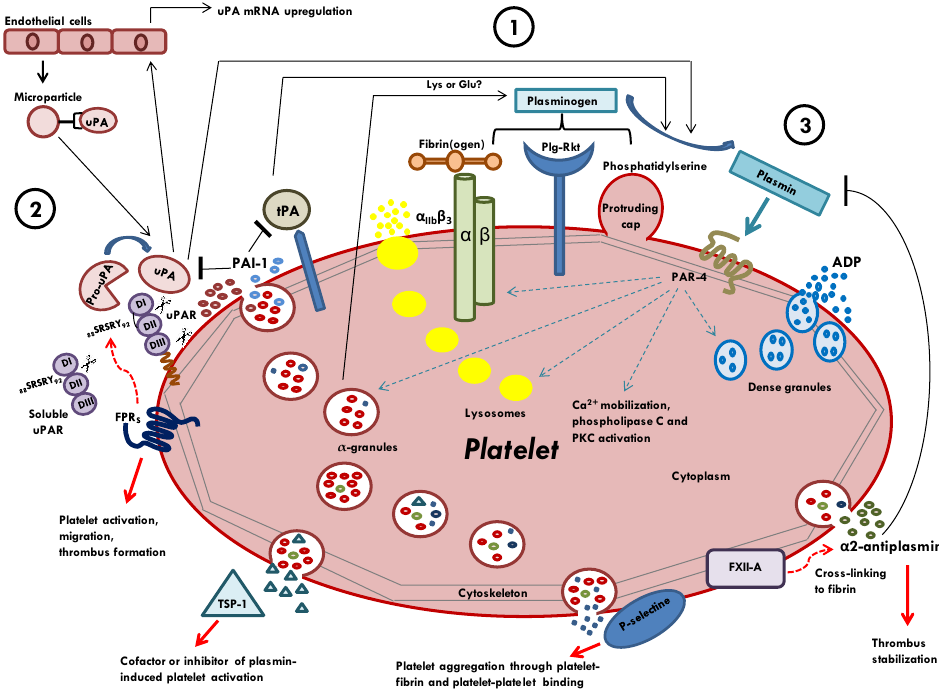
Figure 1. Representation of PAS components contained in or bound to platelets. ( 1 ) Plasminogen can be released from platelet α -granules after thrombin stimulation and can interact with specific receptors on the platelet surface: α IIb β 3, phosphatidylserine-exposing protruding caps, and/or Plg-Rkt, an integral transmembrane receptor. ( 2 ) The two main plasminogen activators are tPA and uPA. tPA derives from both platelets and plasma. Platelet receptors for tPA have not yet been identified. uPA can derive from both α -granules and endothelial cell-derived microparticles. uPA bound to platelet surface upregulates uPA synthesis and release by endothelial cells. Platelets express membrane uPA receptor (uPAR) and release GPI-negative form of uPAR (suPAR). Both GPI-positive and GPI-negative uPAR can interact with FPRs, and they could induce platelet activation, migration, and thrombus formation. Platelets are able to release PAI-1, which is an inhibitor of plasminogen activators and α 2-antiplasmin. α 2-antiplasmin is cross-linked to fibrin by activated coagulation factor XIII (FXIII-A) in order to promote thrombus stabilization. ( 3 ) Following its activation, plasmin can act as platelet activator. After binding to Protease-Activated Receptor 4 (PAR-4), plasmin induces α IIb β 3 expression; α -, δ -granules and lysosomes release, Ca 2+ mobilization, phospholipase C and PKC activation, ADP secretion, and P-selectine expression, thus promoting platelet aggregation. Thrombospondin-1 (TSP-1), released from α -granules, could act as cofactor and/or inhibitor of plasmin-induced platelet